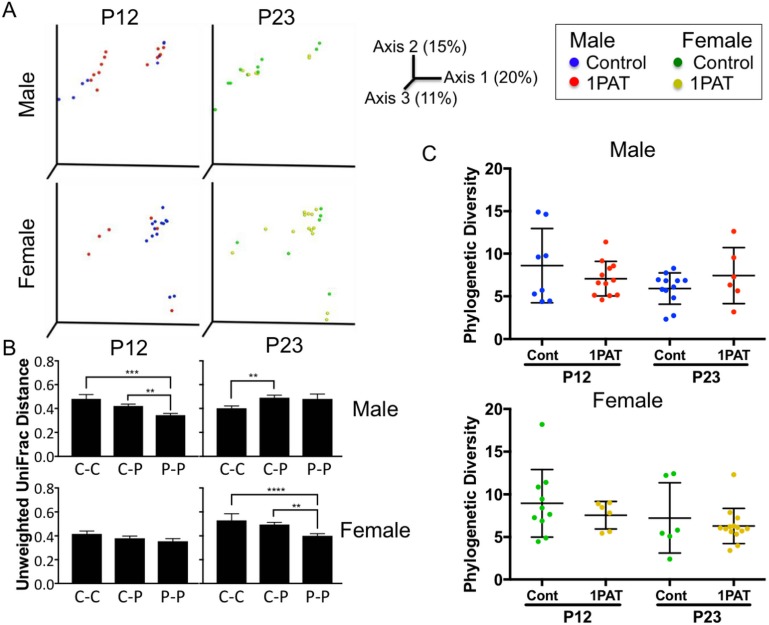
Ileal microbiota characteristics of male and female control and PAT NOD mice.(A) β-diversity, as measured by unweighted UniFrac analysis of ileal microbiota over time (P12, and P23). (B) Inter- and intra-group UniFrac distances. Significance determined by one-way-ANOVA with Tukey method for correction for multiple comparisons. ****p<0.001. M-M, M-F and F-F represent the intra-group distances within males, inter-group distances between males and females, and intra-group distances within females, respectively. (C) α-diversity (Phylogenic diversity (PD)) of ileal microbiota. Statistical significance determined by one-way-ANOVA. *p<0.05; **p<0.01; ***p<0.001; and ****p<0.0001.